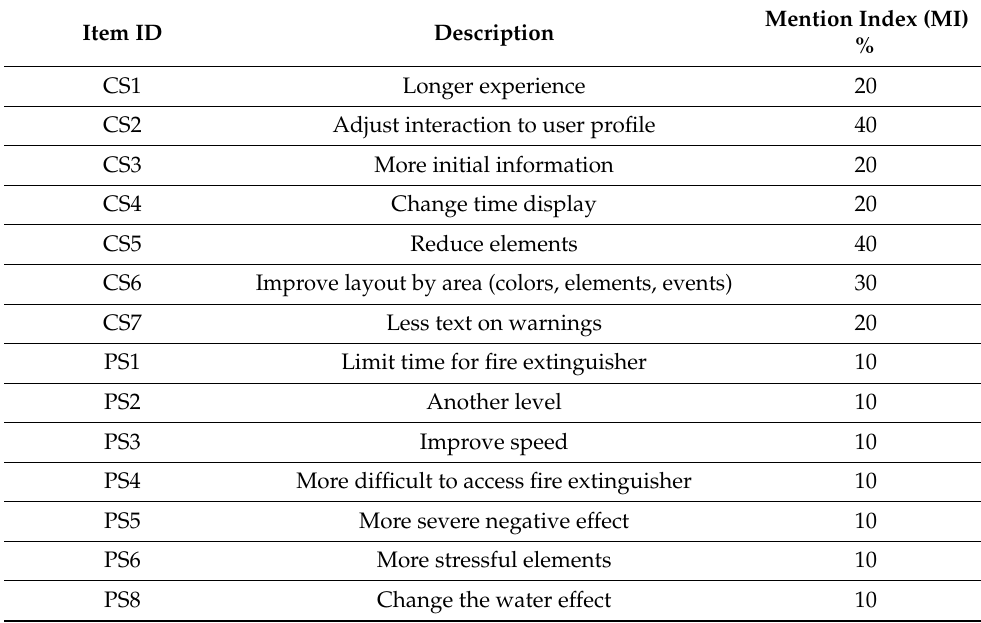
Table 4. Common and particular solutions identified for negative and positive